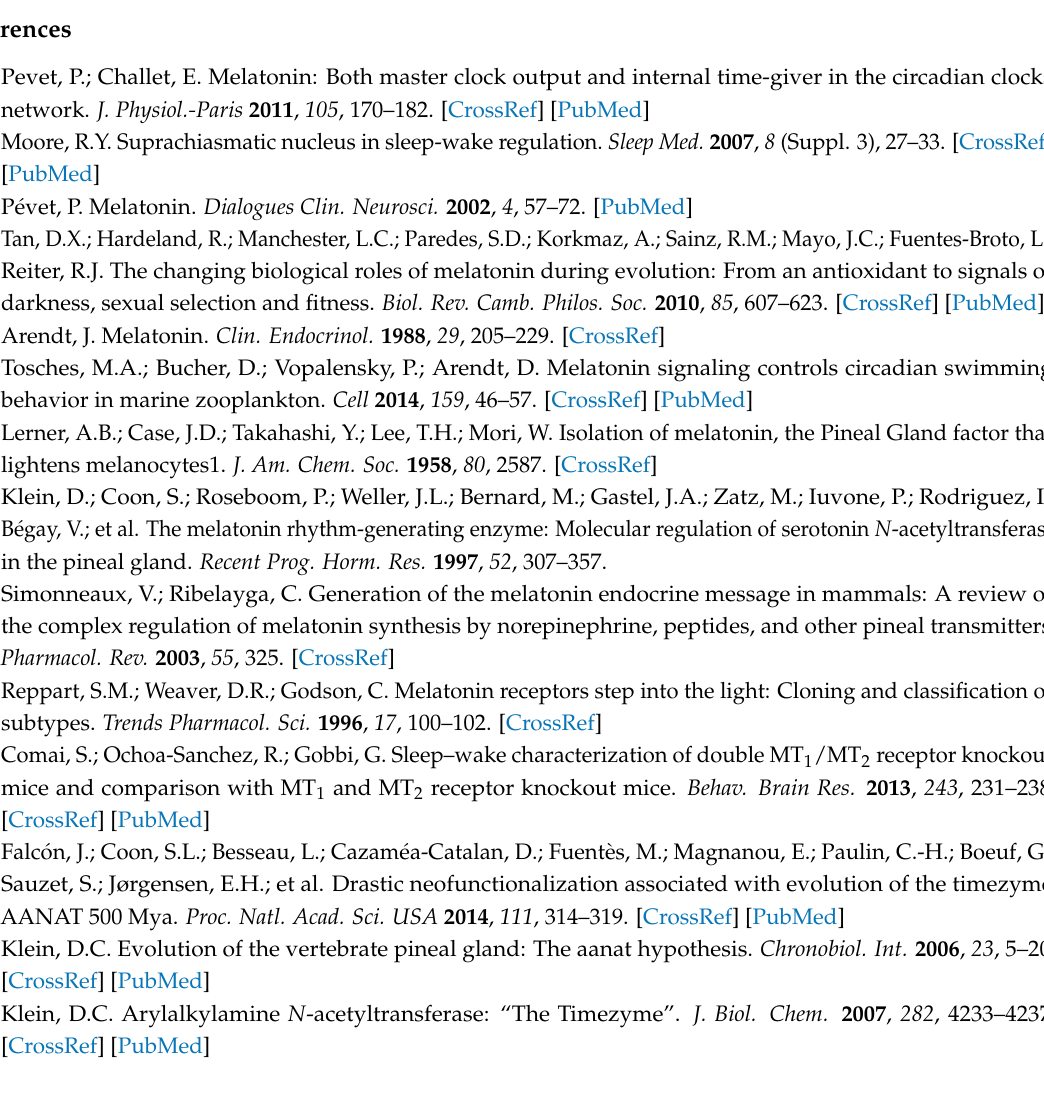
and Primate Aanat genes; Figure S23: Phylogenetic analysis of Perissodactyla, Artiodactyla and Primate Mtnr1a genes; Figure S24: Phylogenetic analysis of Perissodactyla, Artiodactyla and Primate Mtnr1b genes; Figure S25: T. manatus latirostris gene annotations; Figure S26: SRA validation for loss of start codon in exon 1 of the Aanat gene from T. manatus latirostris ; Figure S27: SRA validation for premature stop codon in exon 5 of the Asmt gene from T. manatus latirostris ; Figure S28: SRA validation for single nucleotide insertion in exon 2 of the Mtnr1a gene from T. manatus latirostris ; Figure S29: SRA validation for frameshift mutation in exon 2 of the Mtnr1b gene from T. manatus latirostris ; Table S1: Blast-n output of Bos Taurus and Homo sapiens sequences against the H. amphibius genome; Table S2: Accession numbers of the Aanat orthologues sequences used in phylogenetic analyses; Table S3: Accession numbers of the Mtnr1a orthologues sequences used in phylogenetic analyses; Table S4: Accession numbers of the Mtnr1b orthologues sequences used in phylogenetic analyses; Gene annotations: In silico gene annotations of Aanat , Mtnr1a and Mtnr1b in H. amphibius